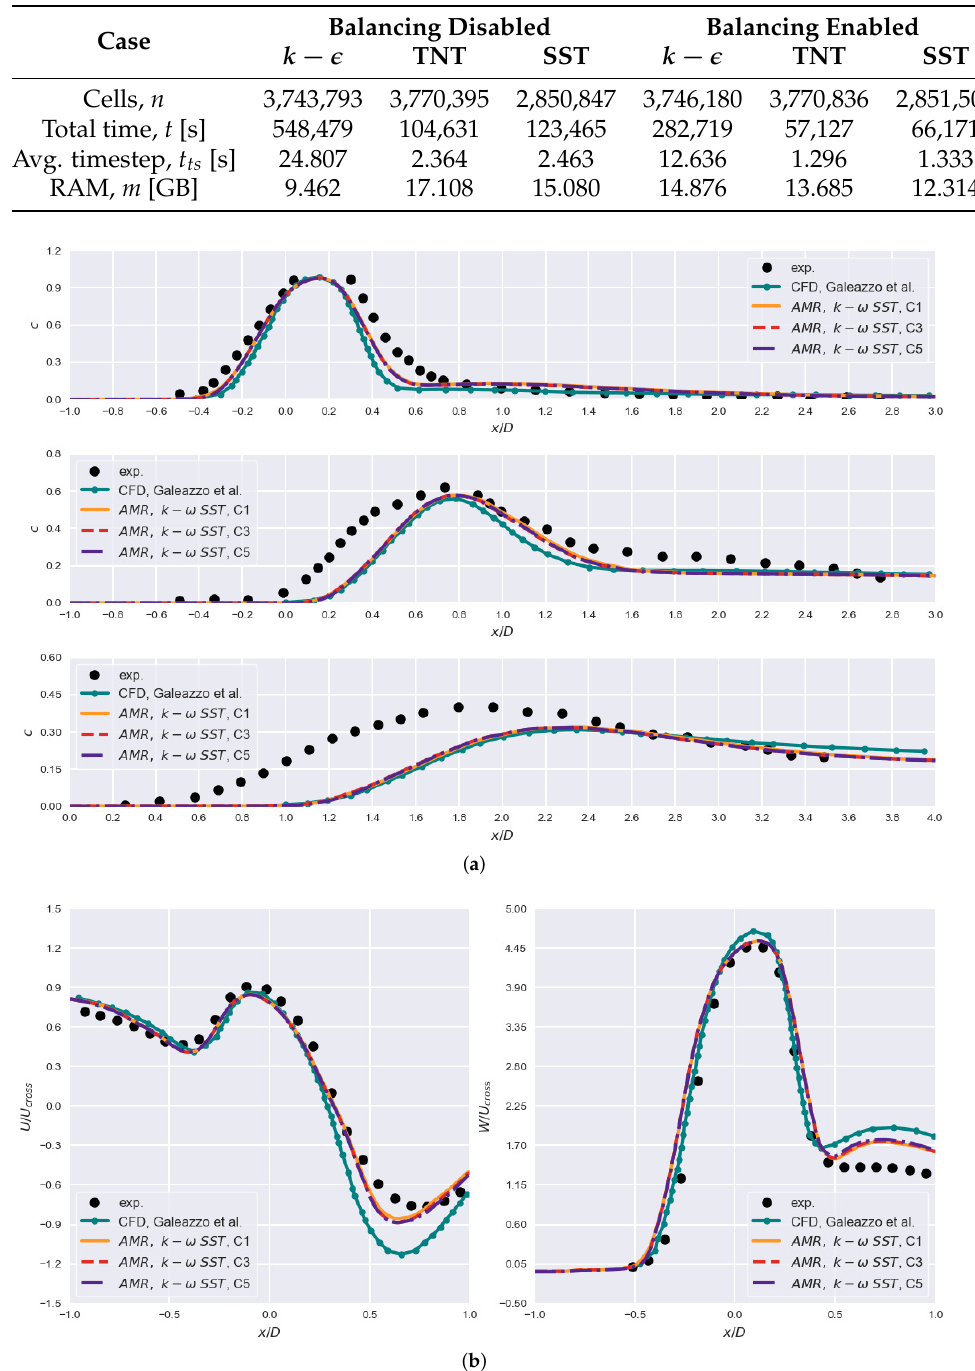
Figure 10. Results for different refinement steps when using AMR and k − ω SST model. Cases 1, 3 and 5 are considered. Case specifics are discussed in Section 2.2 and are noted in Appendix